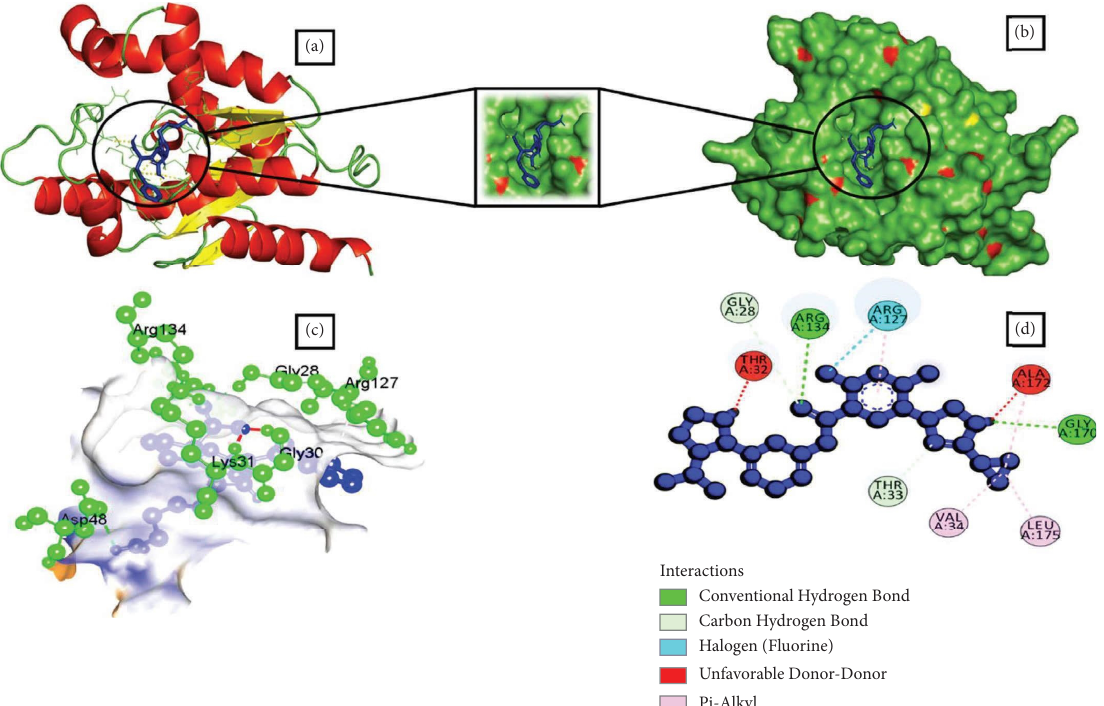
Figure 1: Schematic representation of Shikimate kinase_CHEMBL1237 complex. (a) Pose view of Shikimate kinase_CHEMBL123 complex. (b) Surface view of Shikimate kinase_CHEMBL123 complex. Here, protein is in red, yellow, and green color and ligand is in blue color. (c, d) 3D and 2D interaction of Shikimate kinase_CHEMBL123 complex. Here, protein is in green color and ligand is in blue